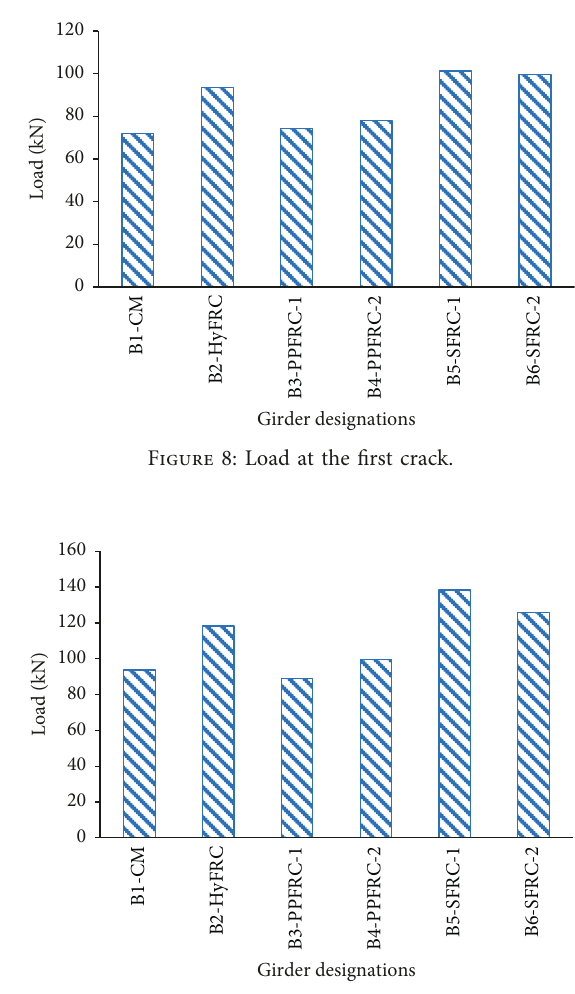
Figure 9: Ultimate loads at failure.